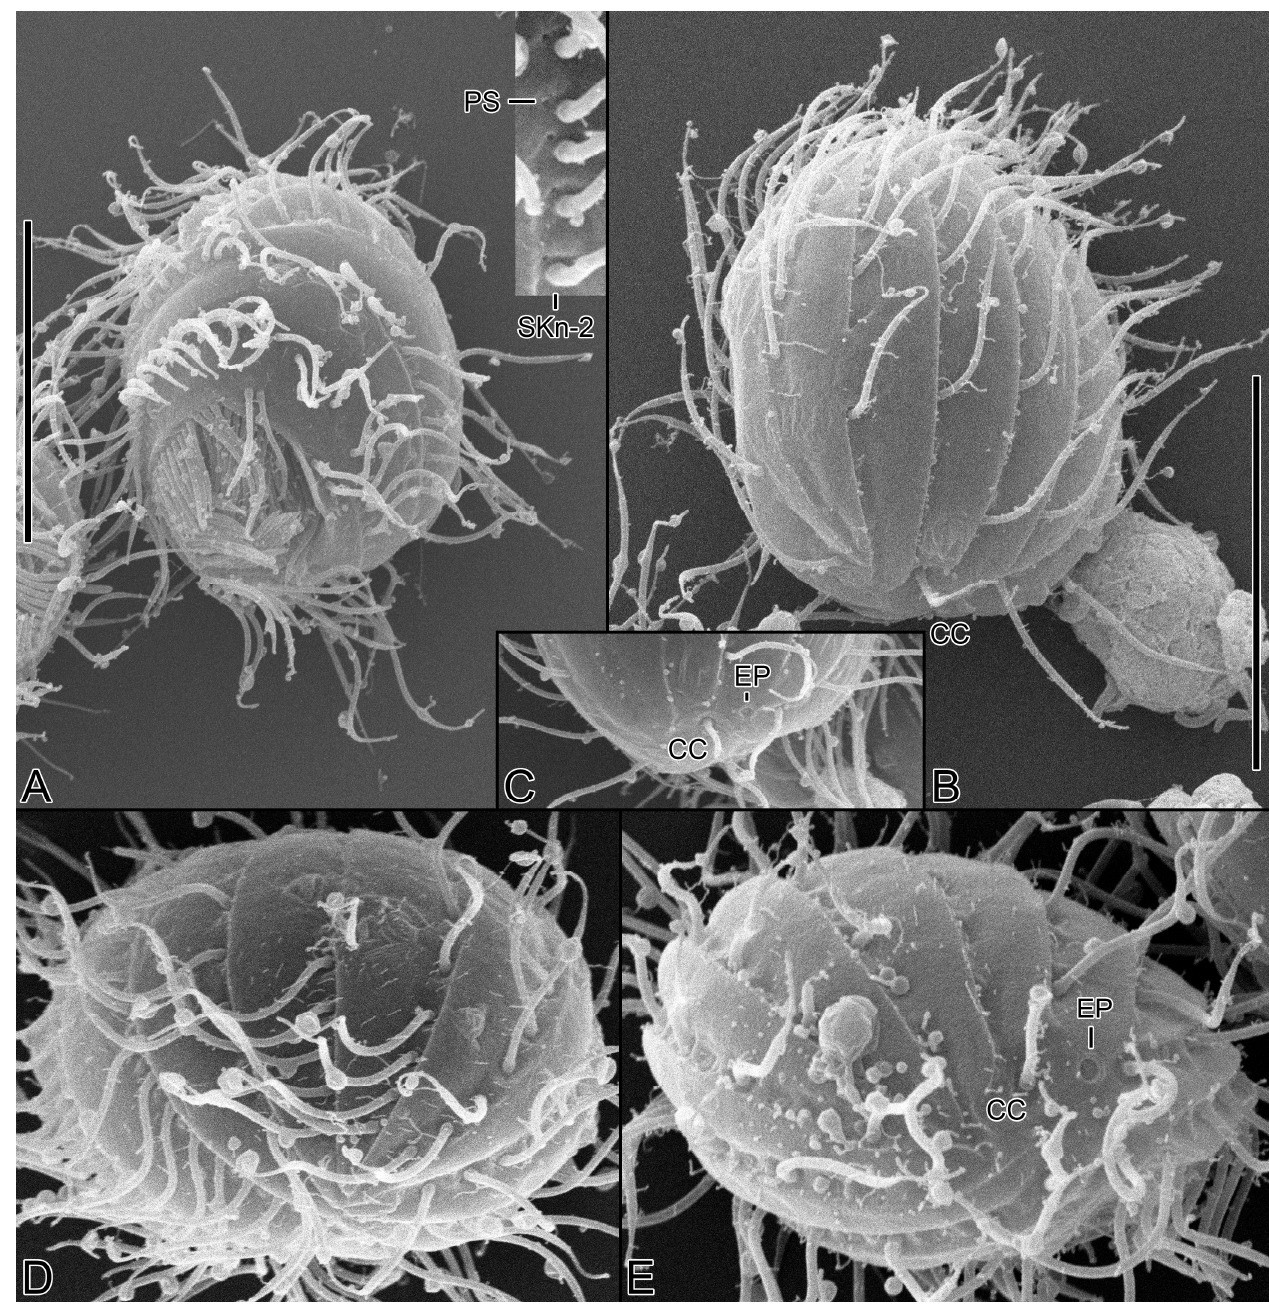
Figure 7. Cinetochilides minimus sp. nov. in the scanning electron microscope. ( A ). Ventral view of a typical cell showing the body shape, somatic cilia, and the parasomal sacs next to kinetids (inset). ( B , C ). Dorsal views showing the ridges along somatic kineties, the dorsal cilia, and excretory pore of contractile vacuole. The caudal cilium has an ordinary length like other somatic cilia. Note that the posterior ends of dorsal kineties are partially non-ciliated. ( D , E ). Apical ( D ) and posterior polar ( E ) view. CC, caudal cilium; EP, excretory pore; PS, parasomal sacs; SK, somatic kineties. Scale bars: 10 µm.